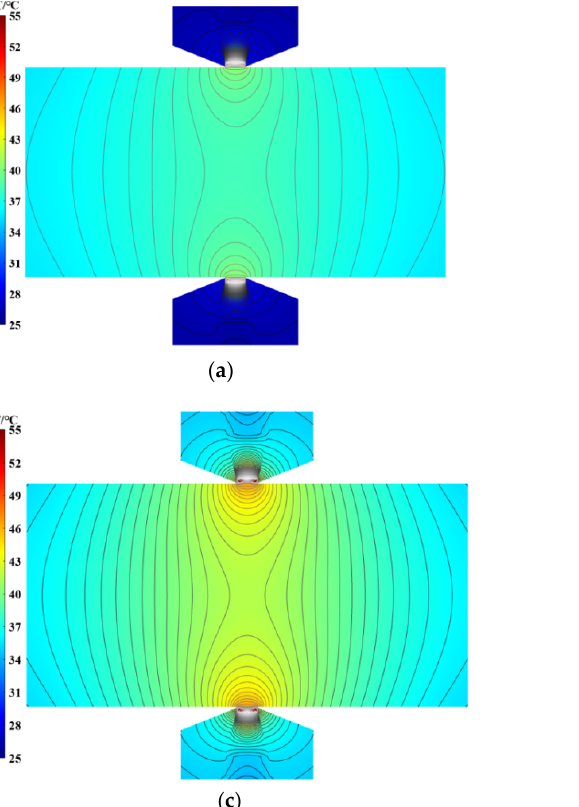
( d ) Figure 9. Temperature cloud of the MR fluid seal under different speed conditions with H ≠ 0: ( a ) 300 rpm; ( b ) 600 rpm; ( c ) 900 rpm; and ( d ) 1500 rpm.